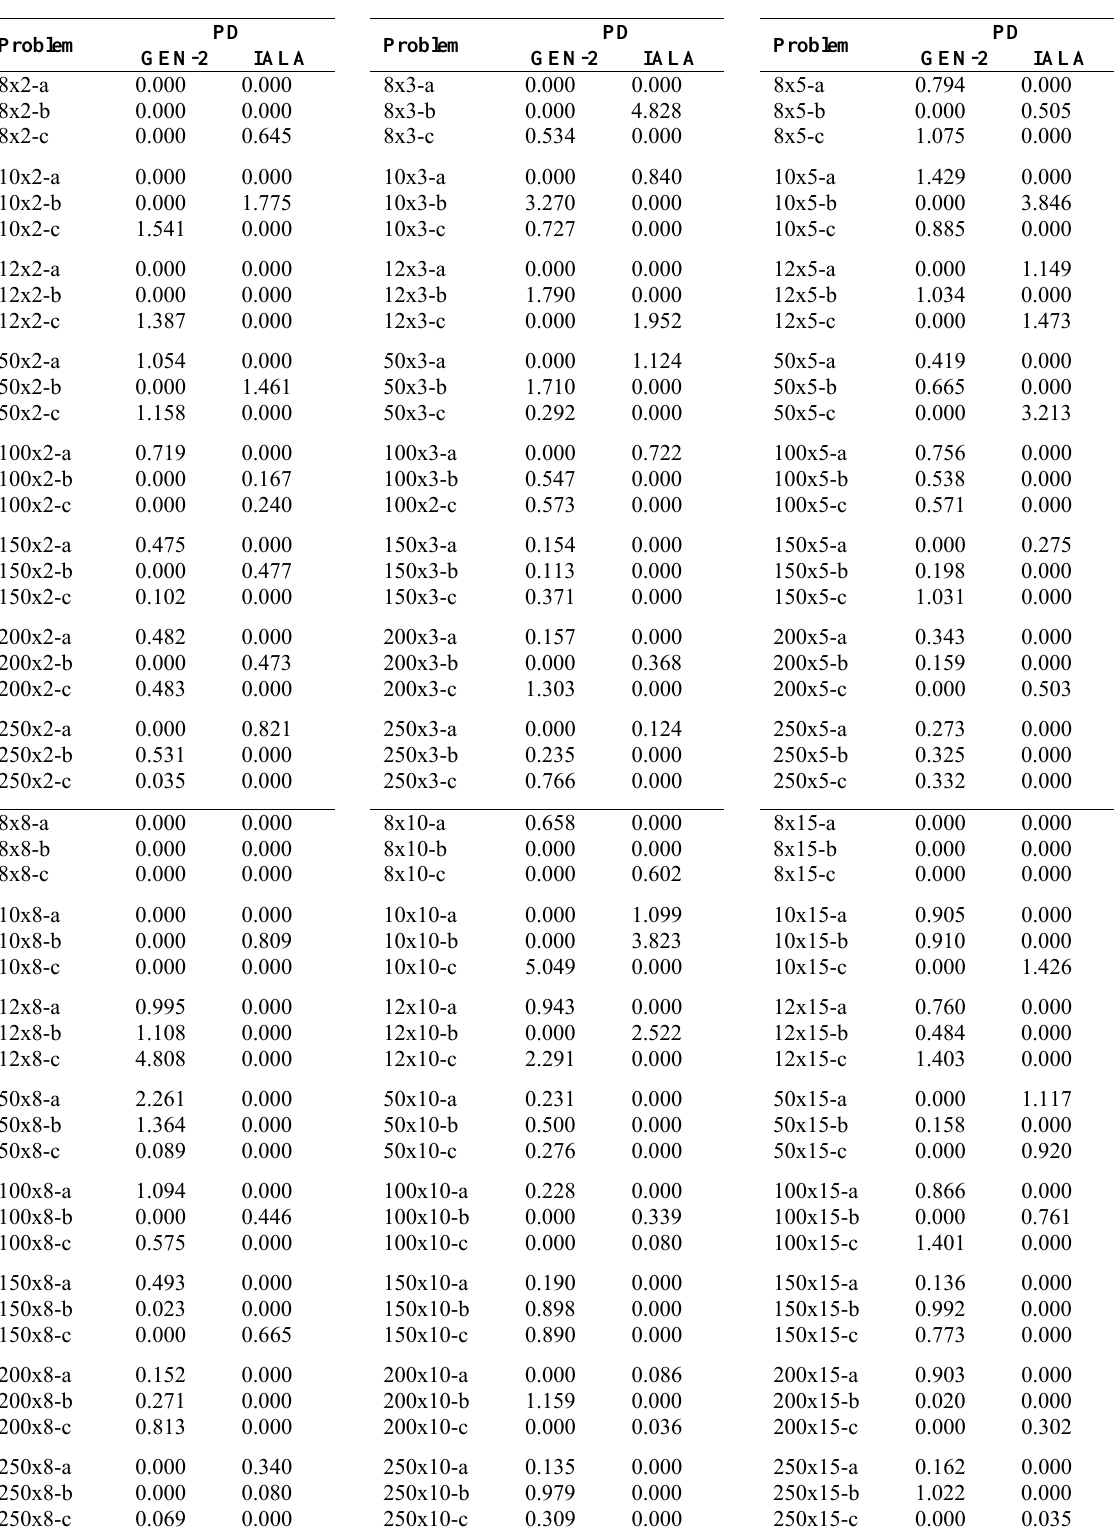
Table 4. Heuristics